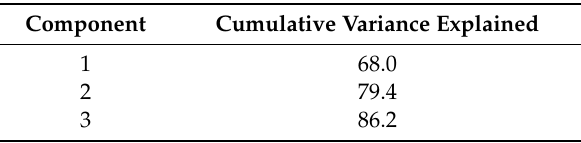
Table 2. Cumulative variance explained by